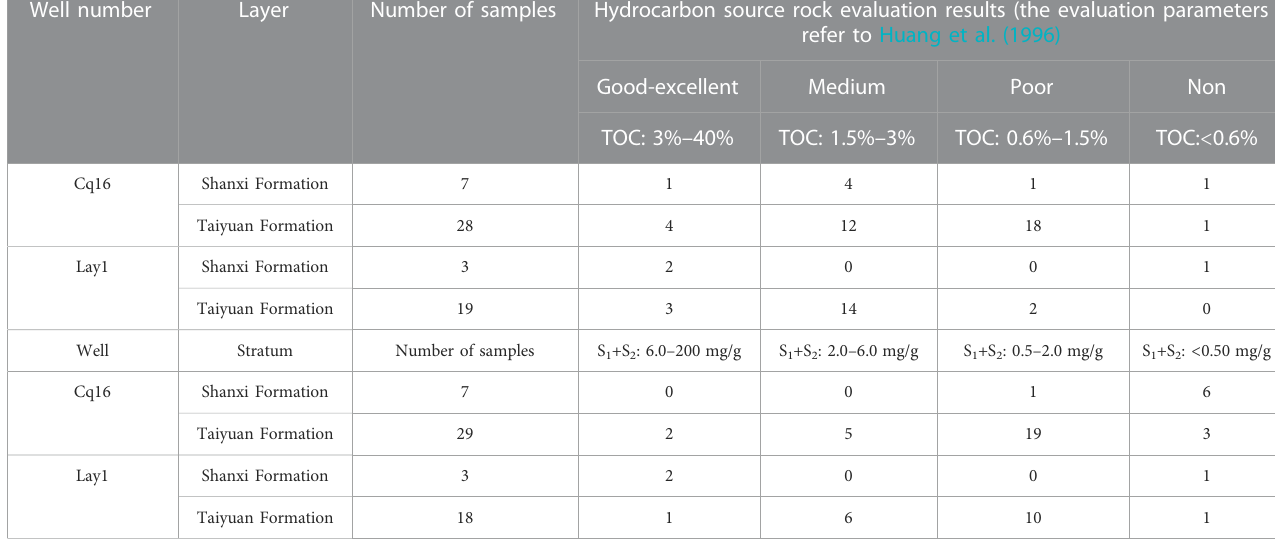
TABLE 1 Evaluation results of the organic matter abundance of marine terrestrial interactive shale. Well